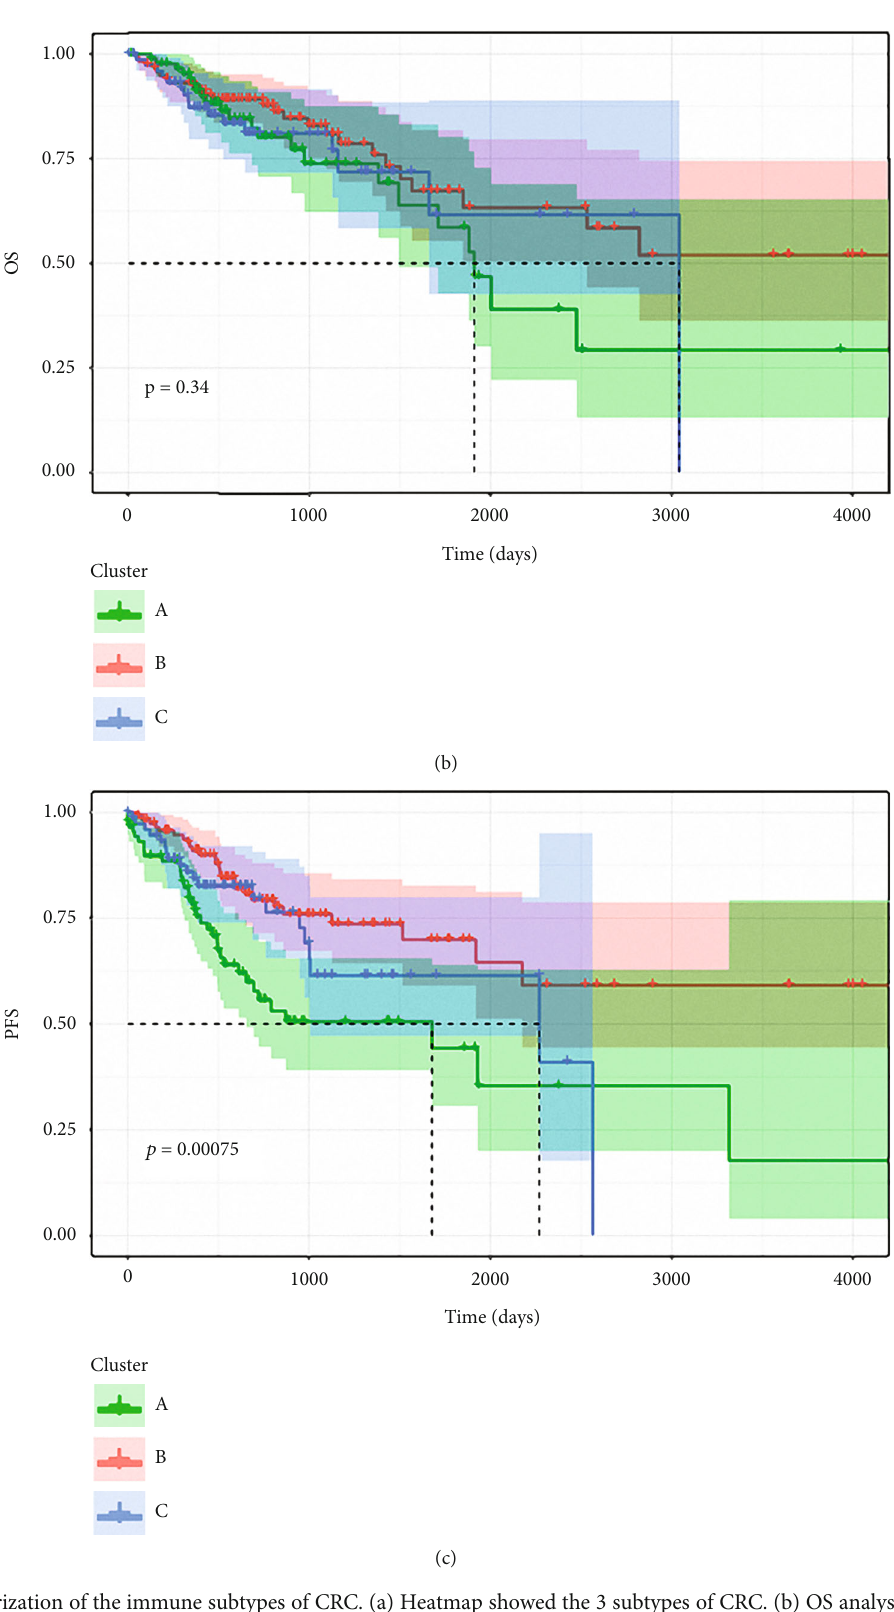
Figure 4: Characterization of the immune subtypes of CRC. (a) Heatmap showed the 3 subtypes of CRC. (b) OS analysis of the 3 subtypes. (c) PFS analysis of the 3